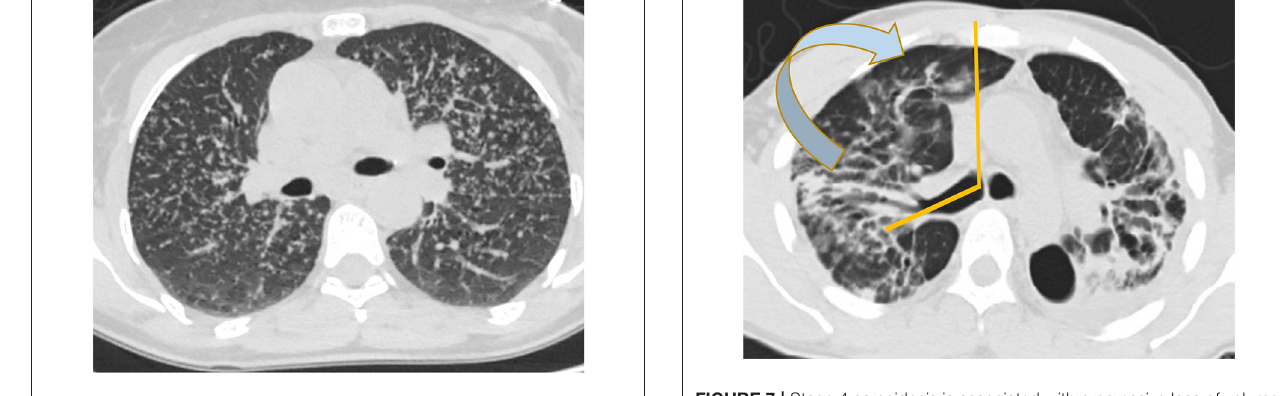
UIP pattern associated with IPF from a UIP pattern of other etiologies, these include the straight-edge sign, anterior upper lobe sign, and exuberant honeycombing, which are more likely to denote an underlying connective tissue disease rather than IPF (19). Non-IPF ILD’s, which usually have better survival than IPF, carry similar mortality to IPF if radiologic honeycombing is present (20).